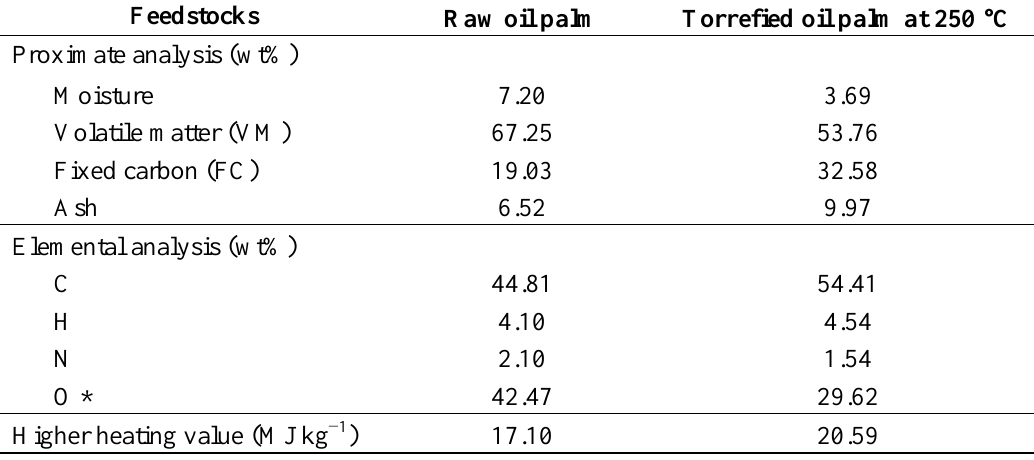
Table 3. Proximate and elemental analyses of the feedstock used in the simulation [28].